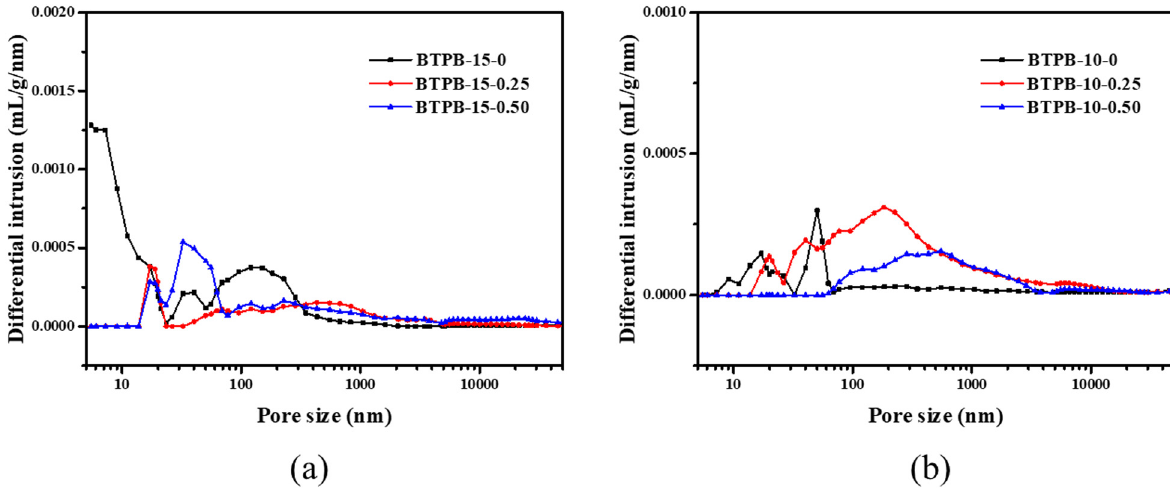
Figure A2: Pore size distributions of selected BTPB ( /TMOS ) aerogels: ( a ) the precursor content of the aerogels is 15 wt% and ( b ) the precursor content of the aerogels is 10